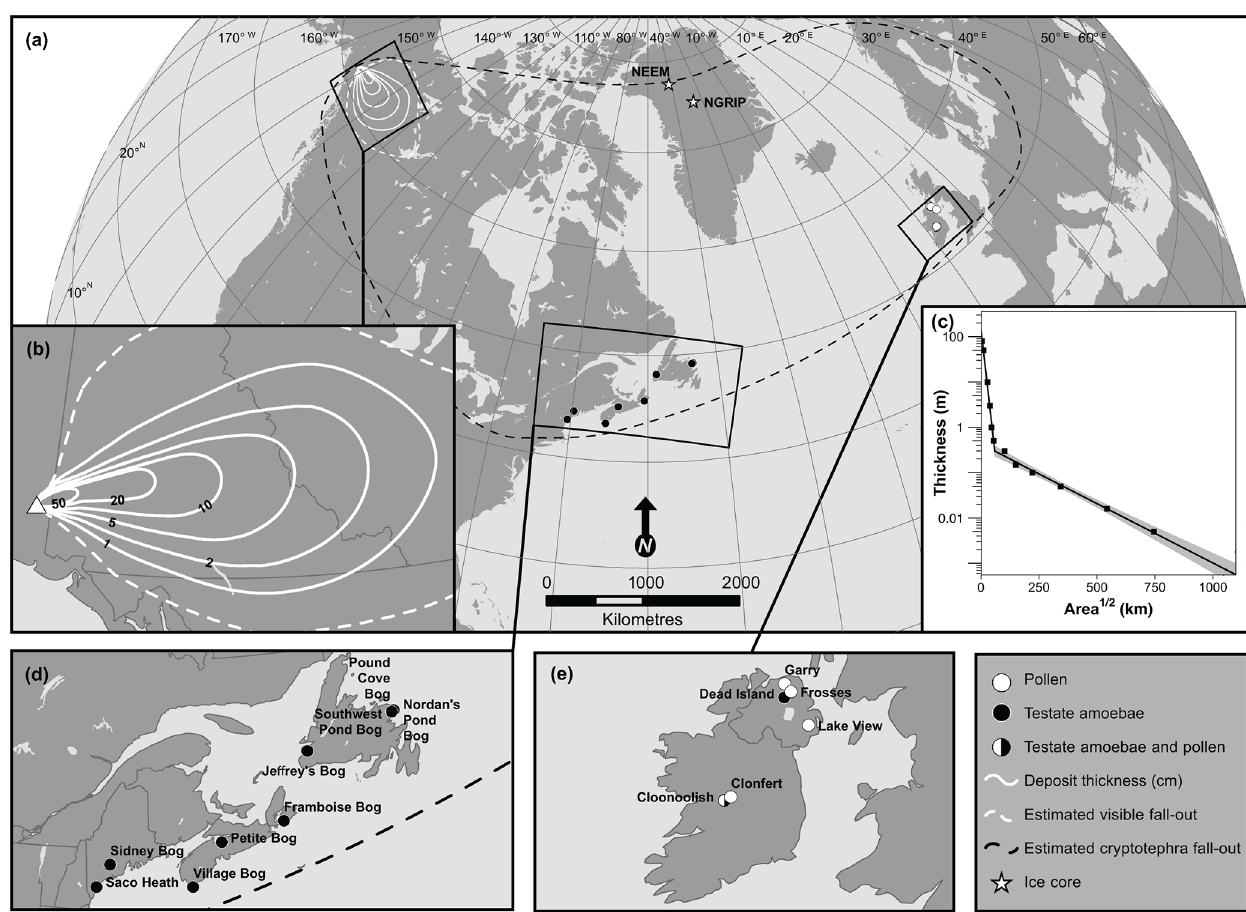
Figure 1. Site and White River Ash east distribution map with thickness data for volume estimate. (a) Location map, highlighting Greenland ice core sites (NEEM: North Eemian; NGRIP: North Greenland Ice Core Project), estimated cryptotephra fallout area and inset map extents. (b) Isopach map synthesised from distal and proximal isopachs (Lerbekmo, 1975, 2008). (c) Plot of deposit thickness (on a log scale) against square root area of isopachs ≥ 0 . 5cm and two-piece exponential fit (black line). The grey shaded area represents the 95% confidence interval of the fitted function. (d) Inset map highlighting testate amoebae sites from northeastern North America. (e) Inset map highlighting testate amoebae and pollen sites from